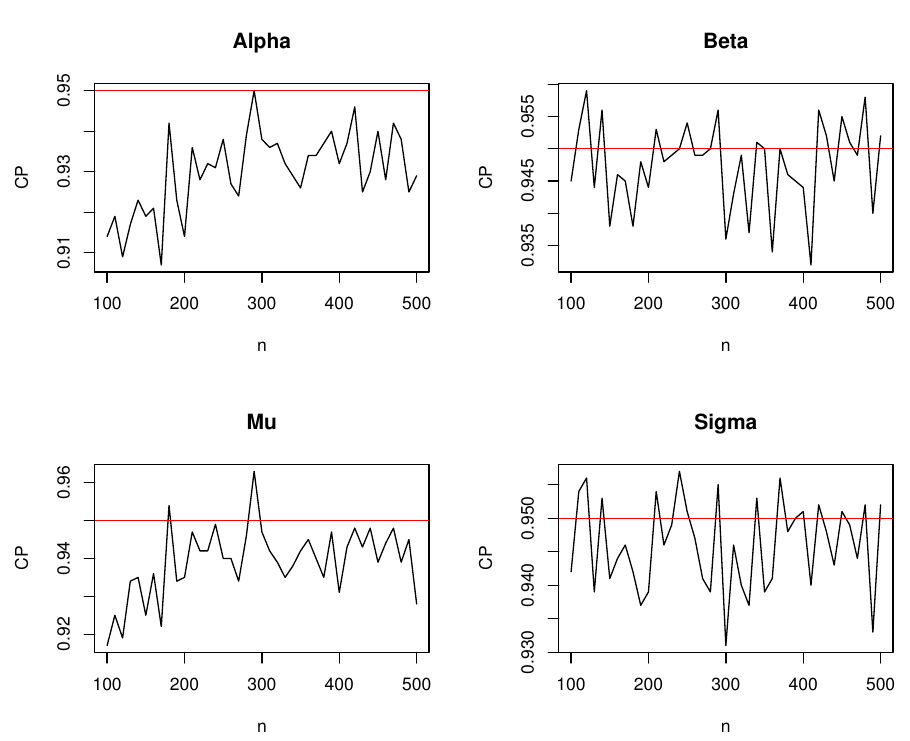
Figure 6. CP of 95% confidence intervals of the MLE ˆ Θ of the vector parameter Θ